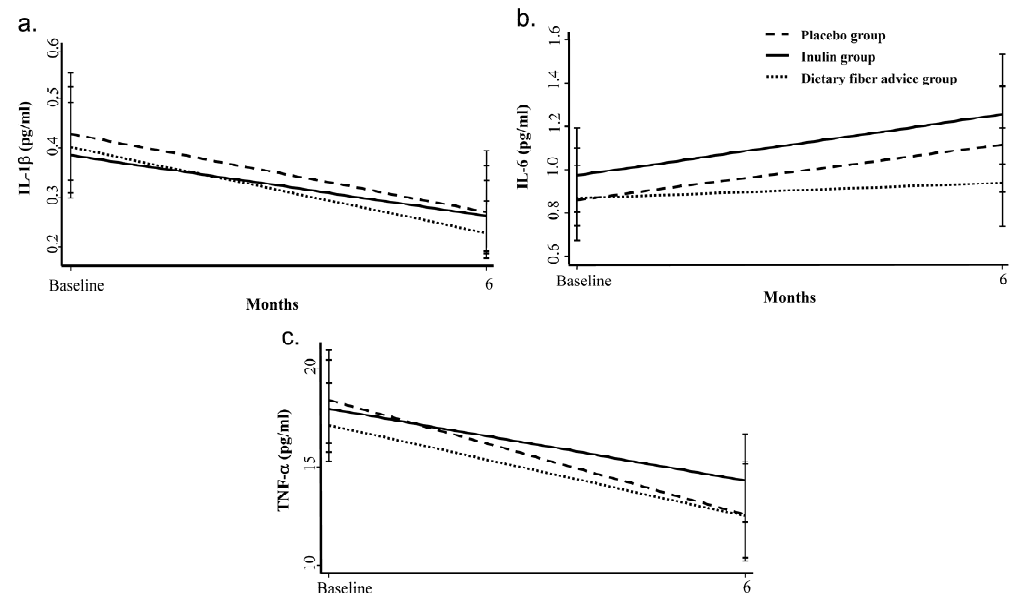
Figure 1. Changes in inflammatory cytokines: ( a ) IL-1 β , ( b ) IL-6, and ( c ) TNF- α over the 6-month intervention. IL-1 β , IL-6, and TNF- α data were not normally distributed. The log transformation was used to make highly skewed distributions less skewed and then the comparison was made among geometric means (anti-log of the arithmetic mean of log-transformed value). Geometric mean for IL-1 β and TNF- α decreased by 34.8% and 25.8%, respectively. Geometric mean for IL-6 increased by 21.5% in all groups. There was no difference between groups by GEE models. GEE, generalized estimating equation; IL, interleukin; TNF, tumor necrosis factor.